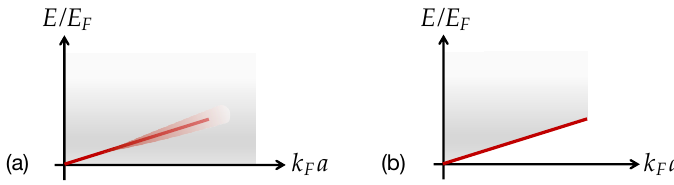
Figure 7. Behavior of repulsive polarons for underlying attractive interactions ( a ) and purely repulsive interactions ( b ). In the former case, the polaron is embedded in a continuum (grey shading) at positive energies, thus resulting in broadening with increasing k F a . By contrast, in the latter case, the continuum lies above the polaron energy and the polaron has an infinite